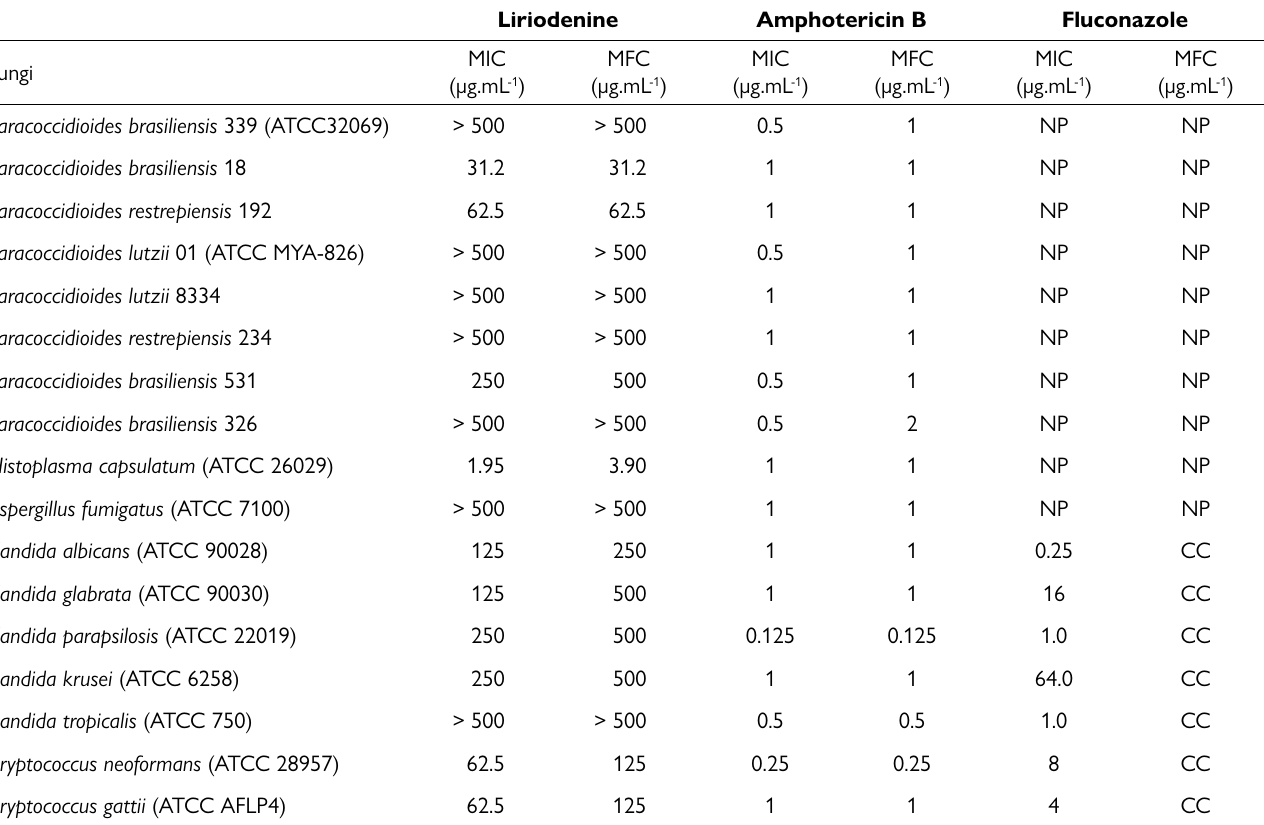
Figure 2. Molecular phylogenetic analysis by the maximum likelihood method using exon 2 of the gp 43 region . The evolutionary history was inferred using the maximum likelihood method based on the Kimura 2-parameter model. The tree with the highest log likelihood is shown. The percentage of trees in which the associated taxa clustered together is shown next to the branches. The tree is drawn to scale, with branch lengths measured in the number of substitutions per site. The analysis involved 11 nucleotide sequences. Evolutionary analyses were conducted in MEGA7. The species names were concordant with the latest accepted taxonomies for the species (old and recent species names). Table 1. Minimum inhibitory concentration (MIC) and minimum fungicidal concentration (MFC) of liriodenine isolated from Annona macroprophyllata, evaluated in 17 fungal